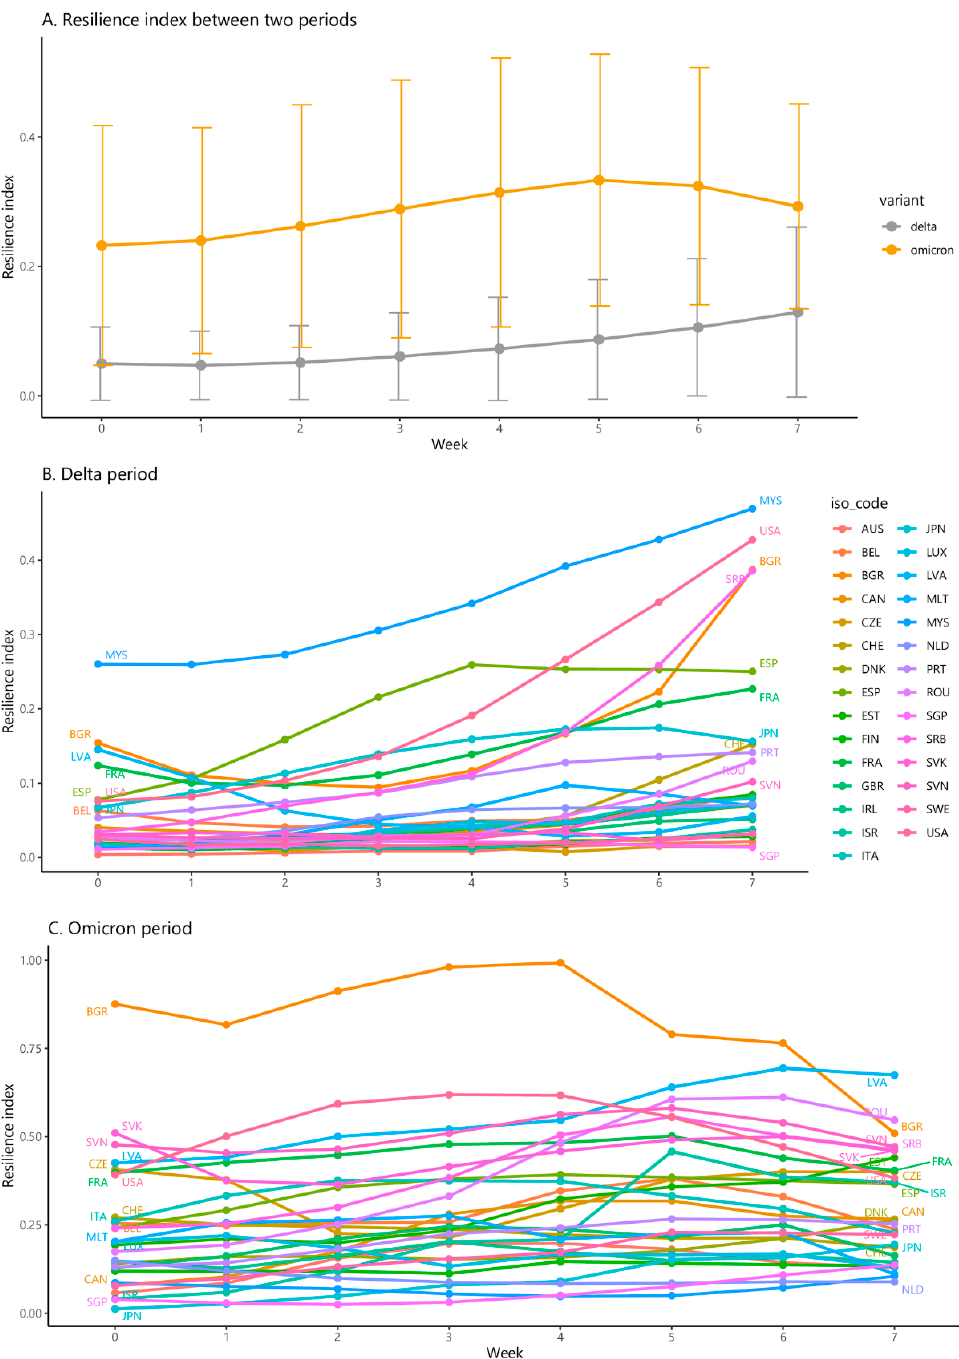
Figure 4. The evolution of the resilience index across 29 countries over the first 8 weeks during the Delta and Omicron variant periods. Country Abbreviations: AUS—Australia, BEL—Belgium,